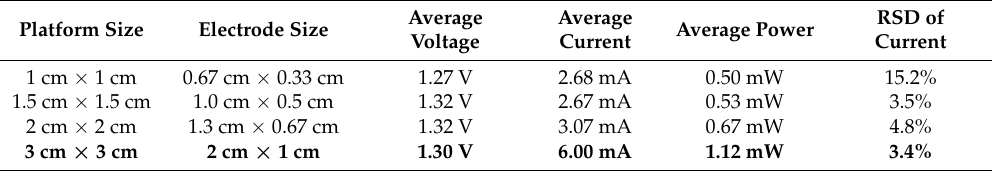
Table 3. Voltage, current, and power of varying chip sizes with proper electrode sizes using ratios with